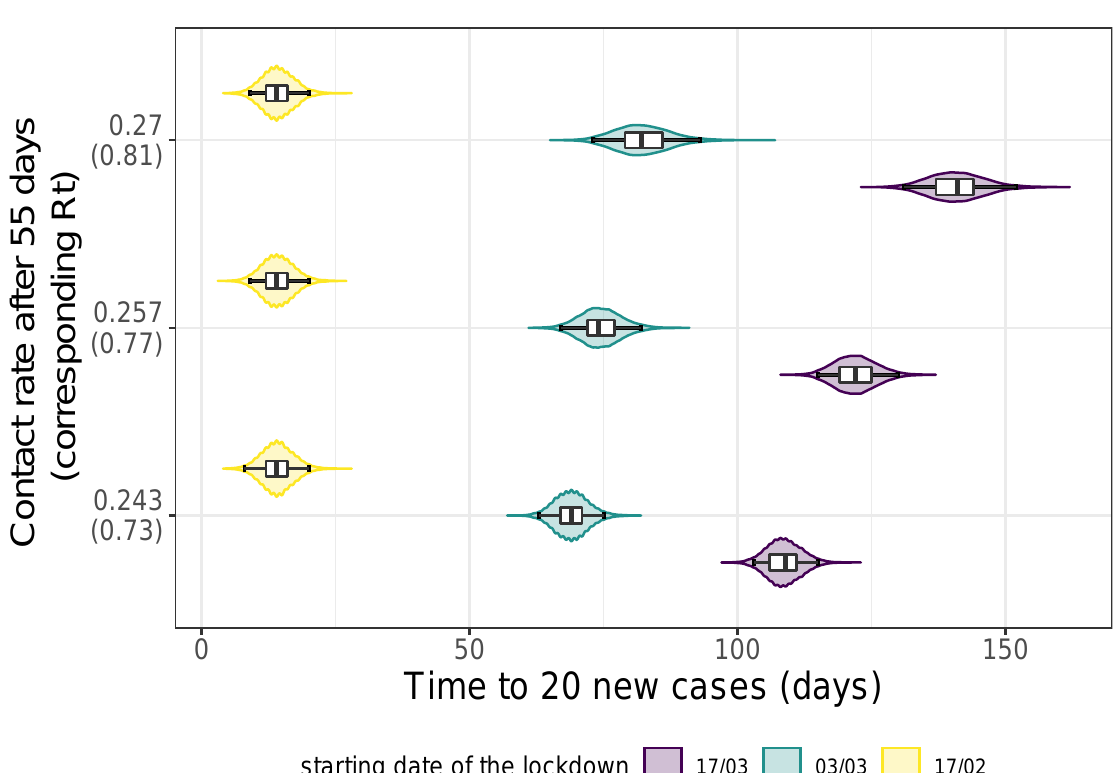
Figure S9 – Effect of the lock-down intensity, stochasticity, and initiation date on the time to 20 new cases without superspreading events. The distributions of the time to 20 new cases (in days since the start of the lock-down) for several contact rate restrictions post 55 first days are plotted on the Y-axis using violin plots and boxplots. In this graph we assume no individual spreading heterogeneity. The colors indicate the different initiation date of the lock-down: in purple it starts on Feb 17, green Mar 03 and yellow on Mar 17 (official start). The box extends from the lower to upper quartiles of the data. The whiskers expand from the 2.5% to the 97.5%